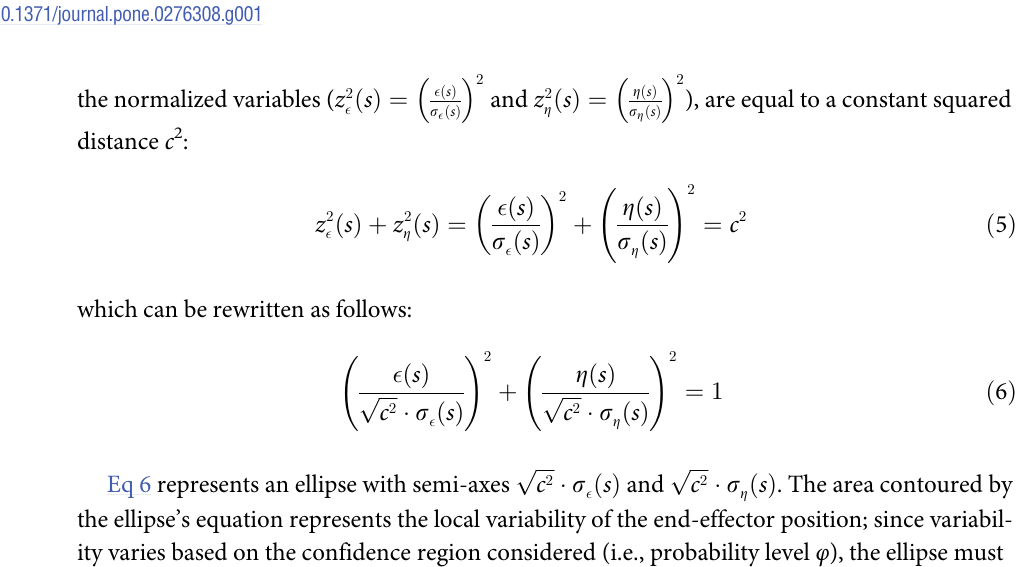
Fig 1. Example of trial trajectories (dash-dotted lines) and their average (thick black line). The light blue ellipse shows the motor variability in the plane P(s) orthogonal to � t � at